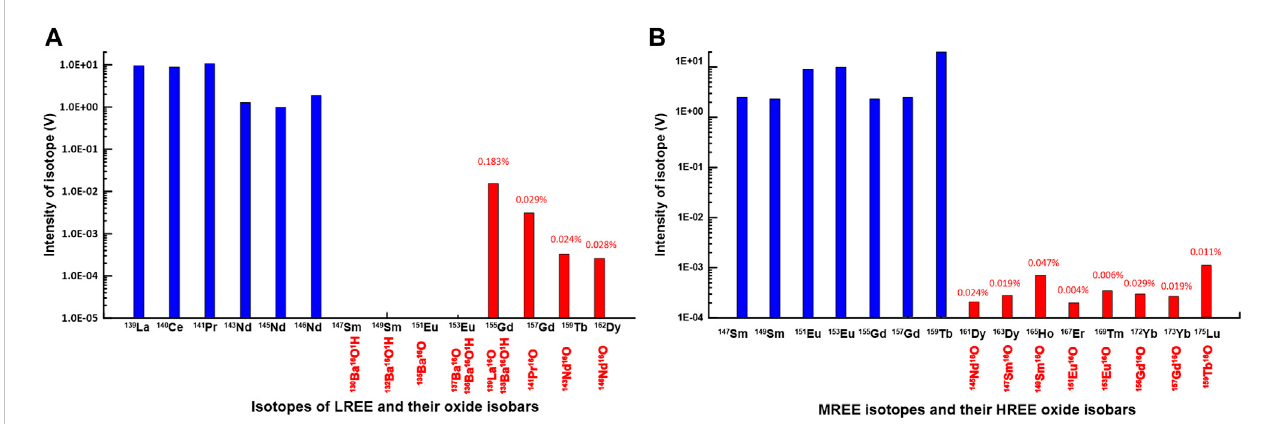
FIGURE 2 (A) Peak intensity (V) of LREE metal isotopes and their oxides in 10 ppb LREE solutions (B) Peak intensity (V) of MREE metal isotopes and their oxides in 10 ppb MREE solutions (see Table 1). The “ % numbers ” indicate % of oxide isobar produced by LREE and MREE standard solutions during MC-ICP-MS (see Table